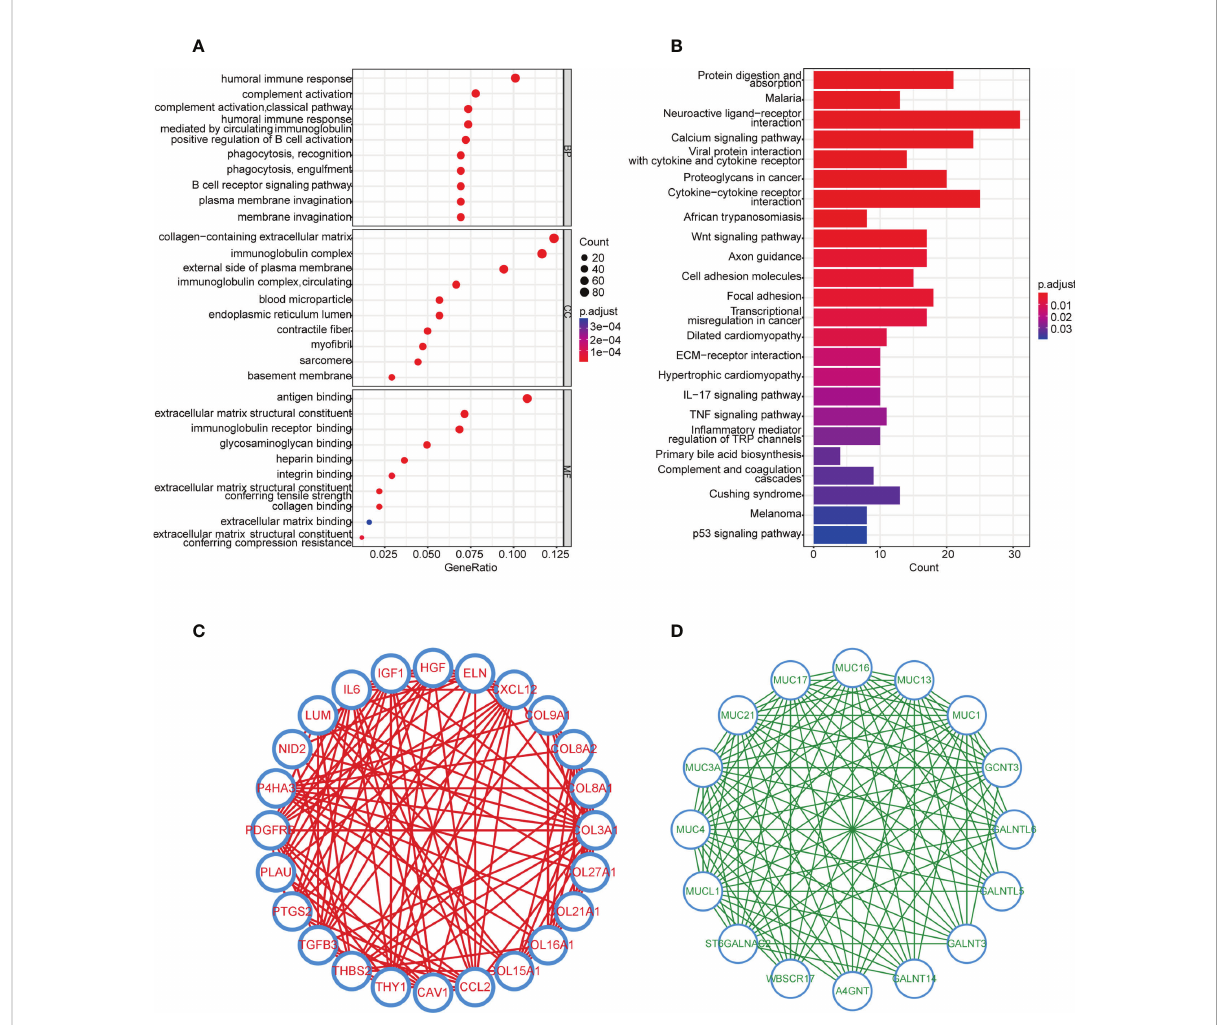
FIGURE 3 Enrichment analysis and hub genes of DEGs in the two subgroups. (A) GO enrichment analysis of upregulated genes in cluster 2, cutoff: q value<0.05. (B) KEGG pathway analysis of upregulated genes in cluster 2, cutoff: q value<0.05. (C, D) Hub genes in upregulated and downregulated genes analyzed by